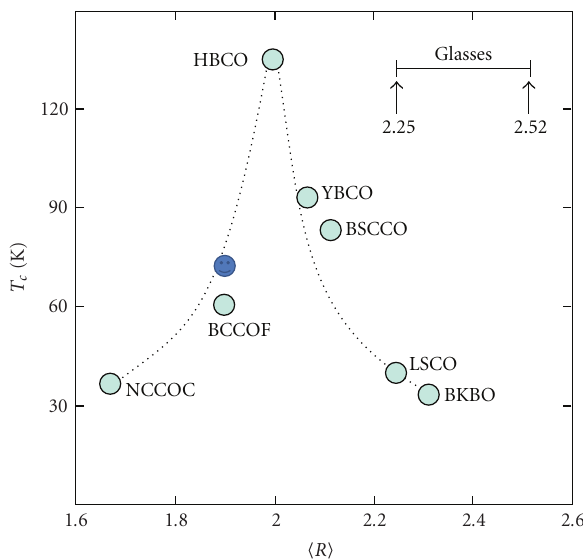
Figure 2: The master function for HTSC, T c max ( (cid:3) R (cid:4) ), provides a least upper bound for bulk layered superconductors, and is believed to be accurate to 10K. This function is based on the zigzag percolative model for self-organized HTSC dopant networks [28, 30]. The original figure [30] has been modified to include the most recent data [34] on BCCOF; the acronyms are as in [30]. Covalent network glasses [20] are centered on (cid:3) R (cid:4) = 2.4, but the stabilizing e ff ect of the rigid CuO 2 planes shifts the cuprate center to (cid:3) R (cid:4) =